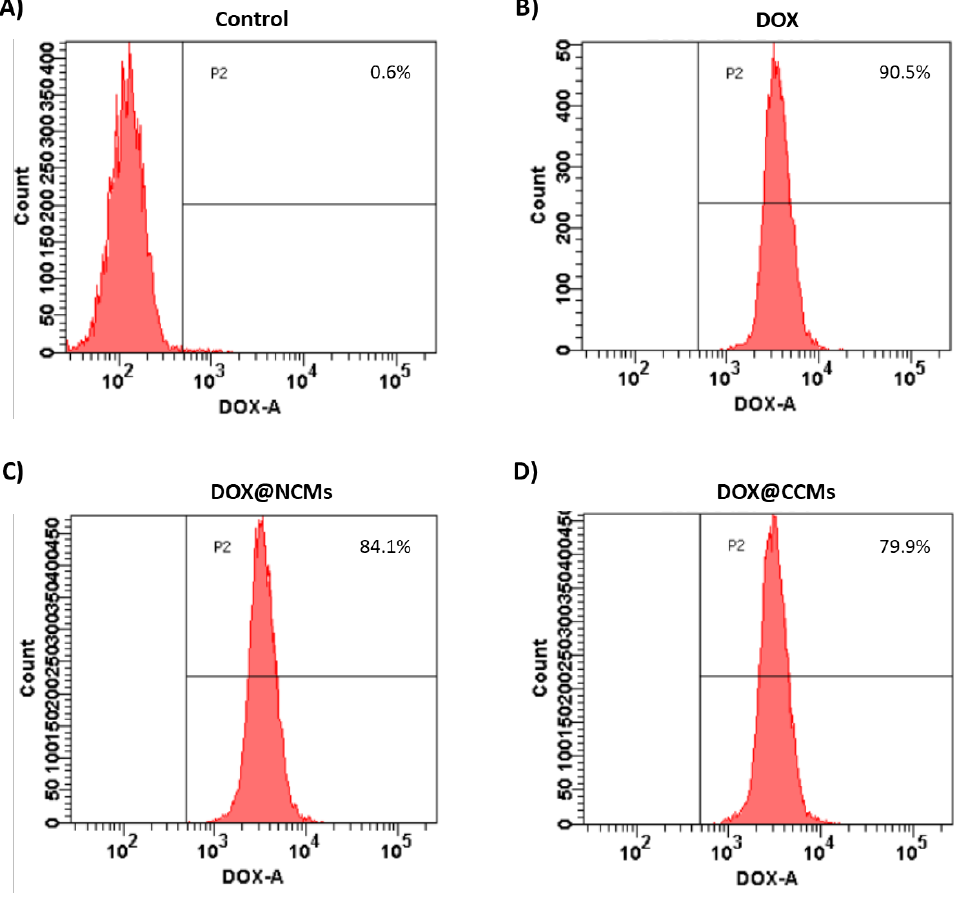
Figure 8. Flow cytometry analysis of HeLa cells treated with PBS ( A ), DOX ( B ), DOX@NCMs ( C ), and DOX@CCMs ( D ) for 9 h at 3 µg/mL of equivalent DOX concentration.